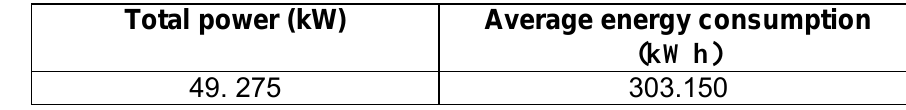
Table 1. Average daily energy balance of the village